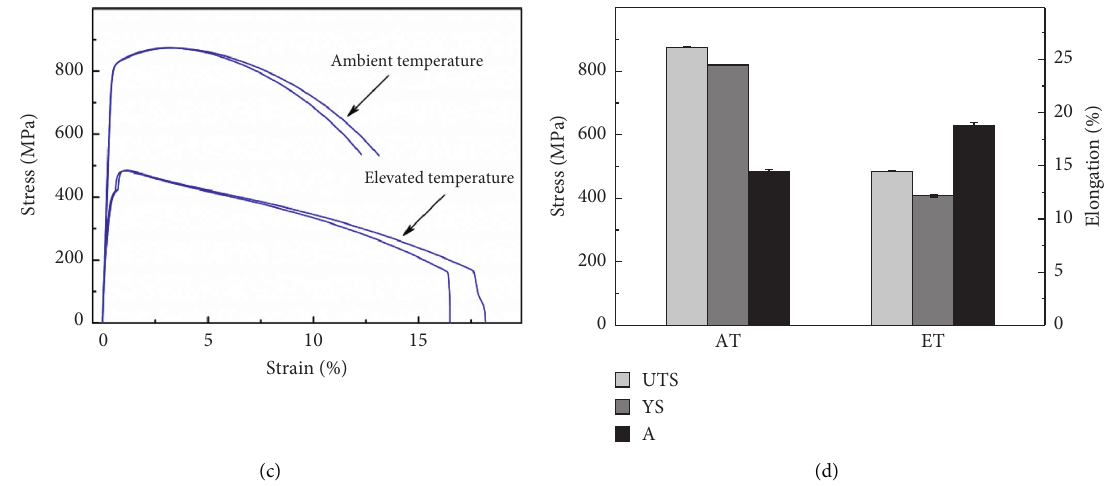
Figure 9: Tensile properties of HAM part. (a) Strain-stress curves and (b) comparison of tensile properties of substrate, AM, and HAM part at ambient temperature; (c) strain-stress curves and (d) comparison of tensile properties of HAM part at ambient temperature and elevated